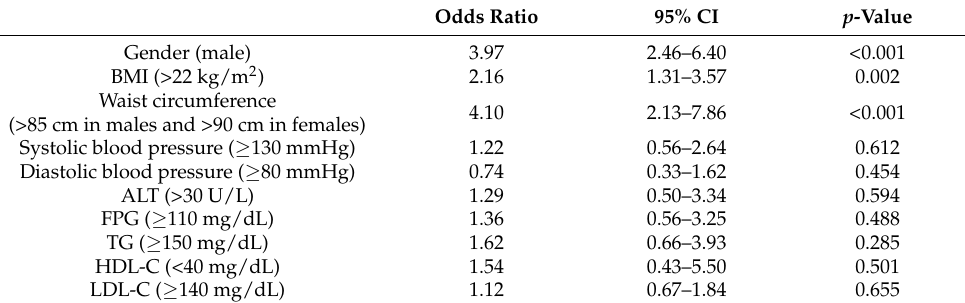
Table 5. Multivariate analysis to detect the factors associated with NAFLD in the subjects with a negative ZJU index and